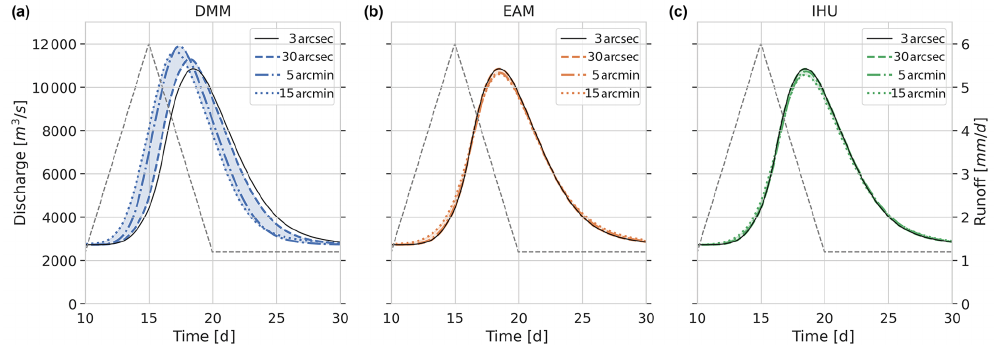
Figure 7. Simulated discharge at the river mouth of the Rhine near Rotterdam for a synthetic accumulated runoff event (grey line) and based on models with native 3arcsec resolution flow directions (black line) in comparison to upscaled flow directions based on the DMM (blue; a ), the EAM (orange; b ) and IHU (green; c ) at a 30arcsec (dashed line), 5arcmin (dash-dotted line) and 15arcmin (dotted line) resolution. Note that the dimulated discharges for the 30arcsec EAM and IHU runs largely overlap with that of the native 3arcsec